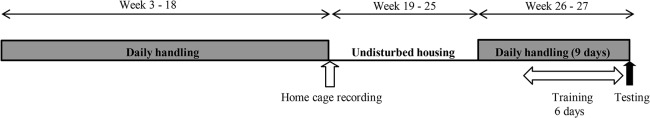
Timeline of the study.The initial handling phase (week 3–18) was part of a study reported elsewhere [52].